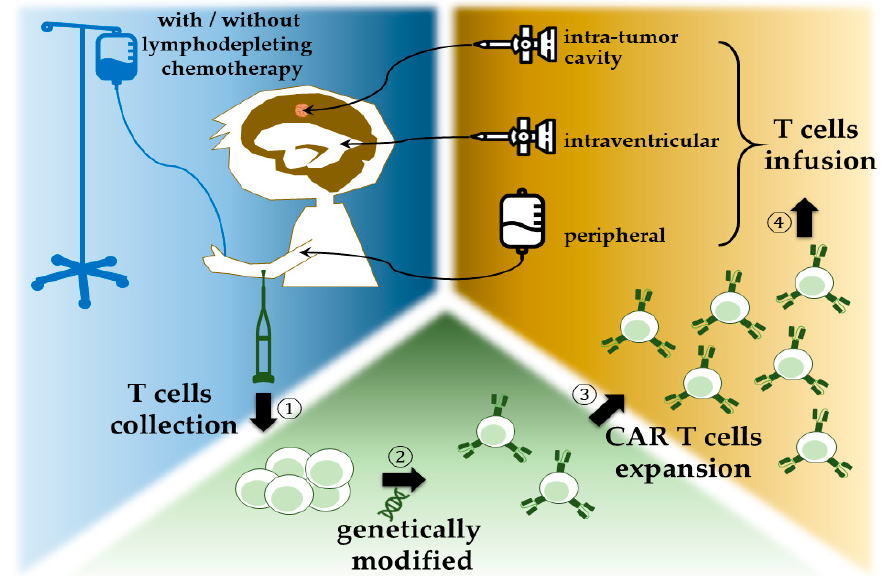
Figure 2. Protocol of CAR T-cell therapy: (1) T cells are gathered from patient. (2) CAR structure is engineered into the collected T cells. (3) The modified CAR T cells are augmented to sufficient amounts. (4) CAR T cells are infused back into the patient via either catheter into intratumor cavity or intraventricular, or through peripheral infusion.